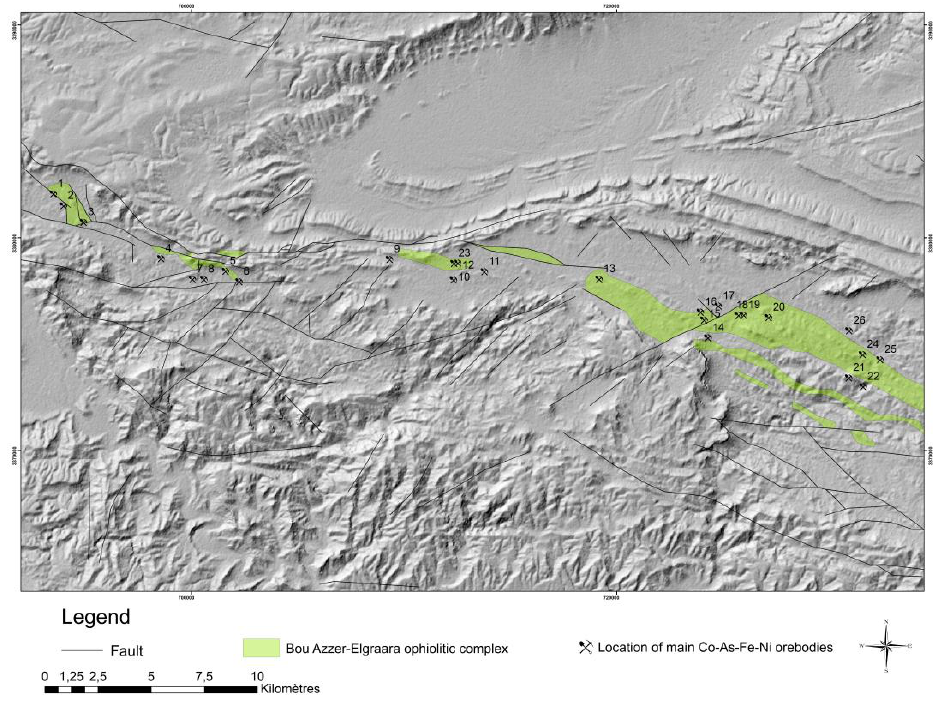
Figure 3. Localization of Bou Azzer–El Graara ophiolitic complex and the main Co-As-Fe-Ni orebod- ies: 1. M é choui, 2. Khder, 3. Nickeline vein, 4. Taghouni, 5. Bou Azzer Vein No. 2, 6. Bou Azzer